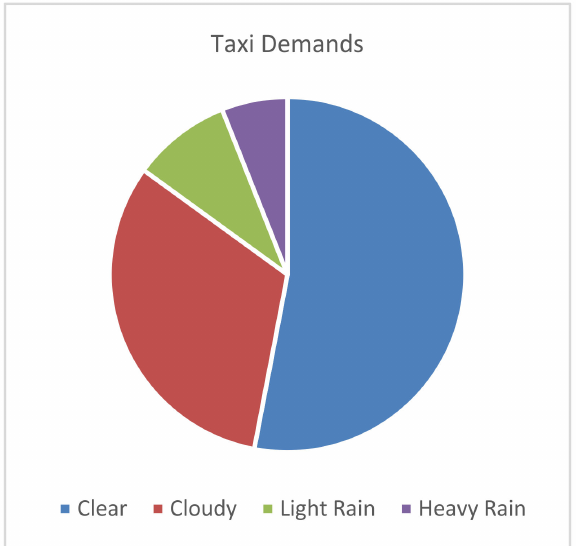
Figure 10. General distribution by percentages of different weather